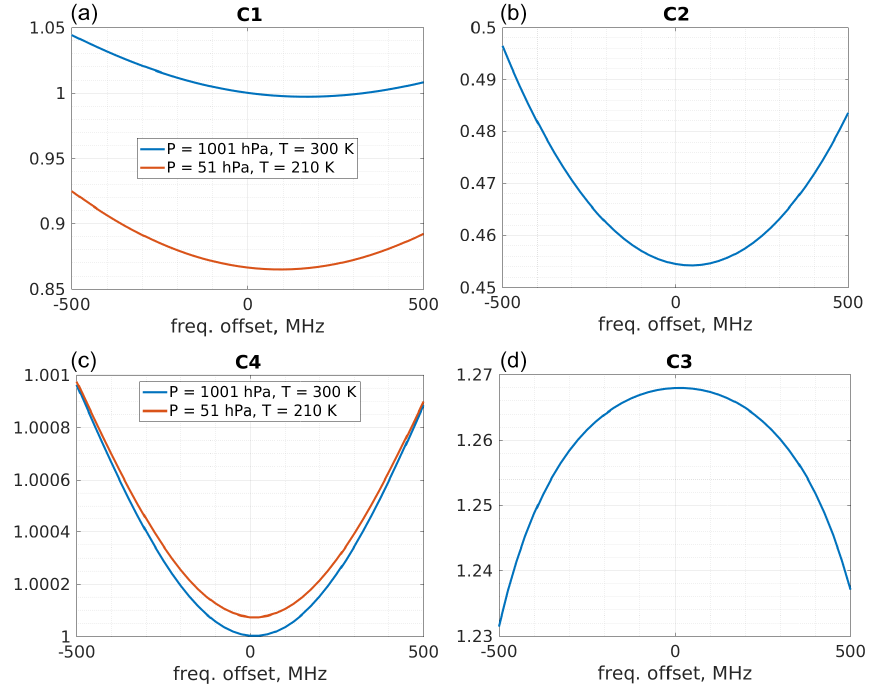
Figure 3. Calibration coefficients from an example AUX_CAL. The top panels are transmissions through the Rayleigh channel; bottom panels are for the Mie channel. In the left plots, C 1 and C 4 correspond to the transmission of broad Rayleigh–Brillouin spectra. As these spectra are broad and flat, they do not vary much with Doppler shift. In the right plots, C 2 and C 3 correspond to the transmission of narrow spectra and are sensitive to local variations of transmissions.